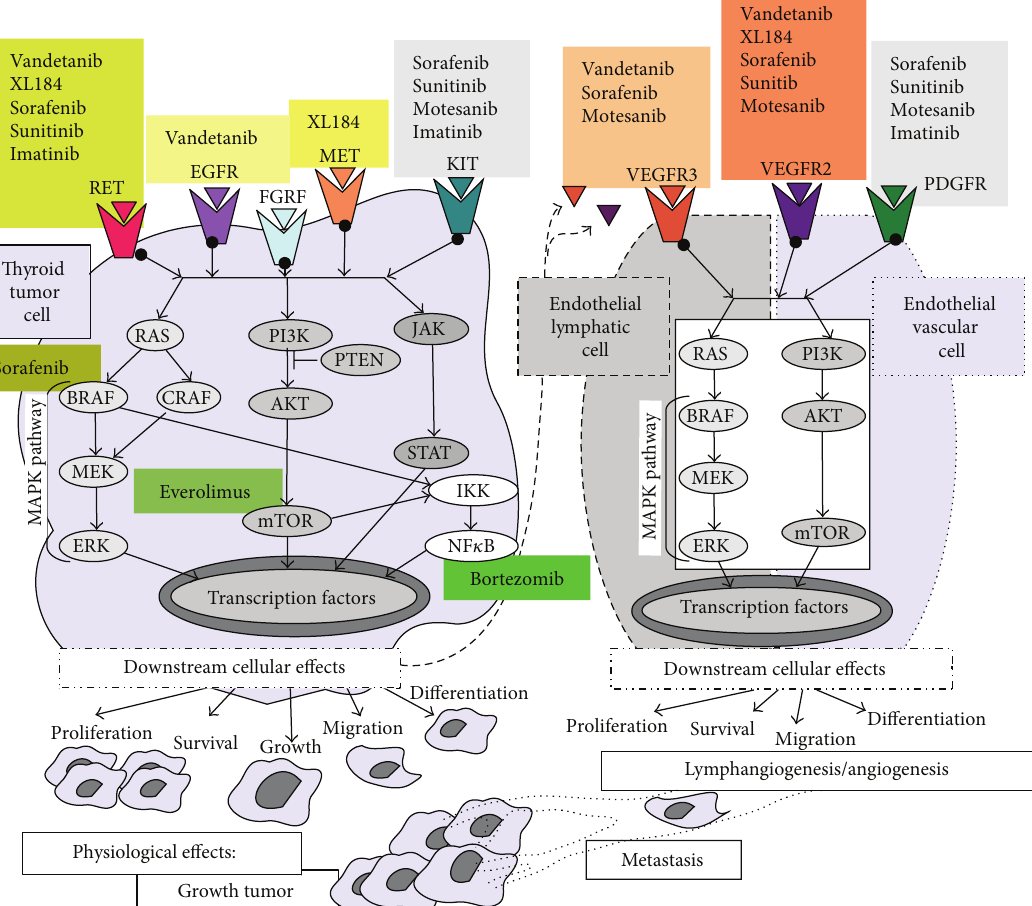
Figure 1: This figure schematically shows the tyrosine kinase receptors, such as RET, EGFR, FGFR, MET, KIT, VEGFR, PDGFR, and some of their downstream effectors. The two most important oncogenic signaling pathways are PI3K/AKT/mTOR and Ras/Raf/MEK/ERK. The activation of the pathways may transduce different transcription factors and induce tumor and endothelial cell proliferation, survival, migration, with subsequent tumor growth, lymphangiogenesis/angiogenesis, and metastasis. Moreover, the main tyrosine kinase inhibitors and their targets are